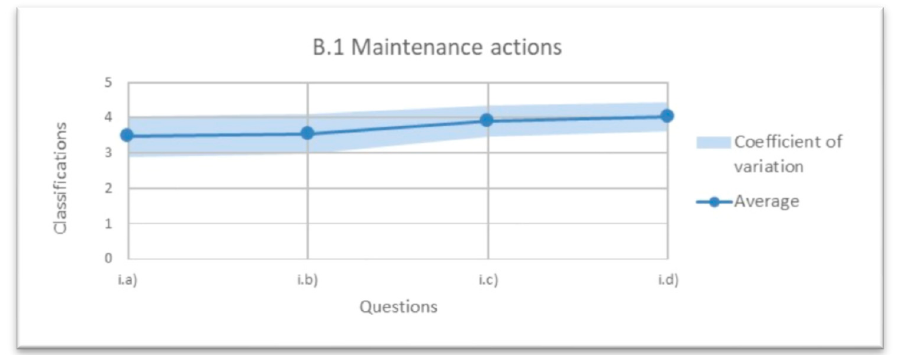
Figure 12. Average ratings of maintenance actions.